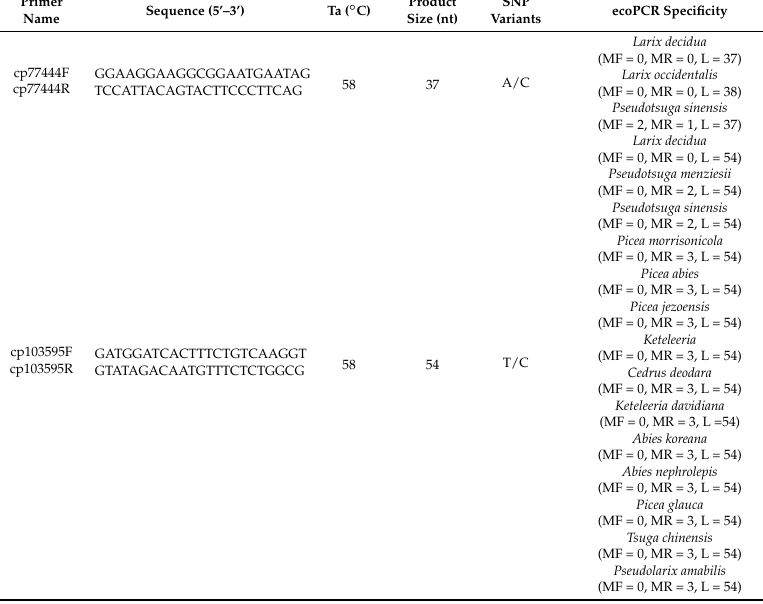
Table 2. Larix primer pairs with the corresponding annealing temperature (Ta), product size, the possible single-nucleotide polymorphism (SNP) variants and ecoPCR specificity indicated by possible matches (MF: mismatches in forward primer; MR: mismatches in reverse primer; and L: length of DNA target